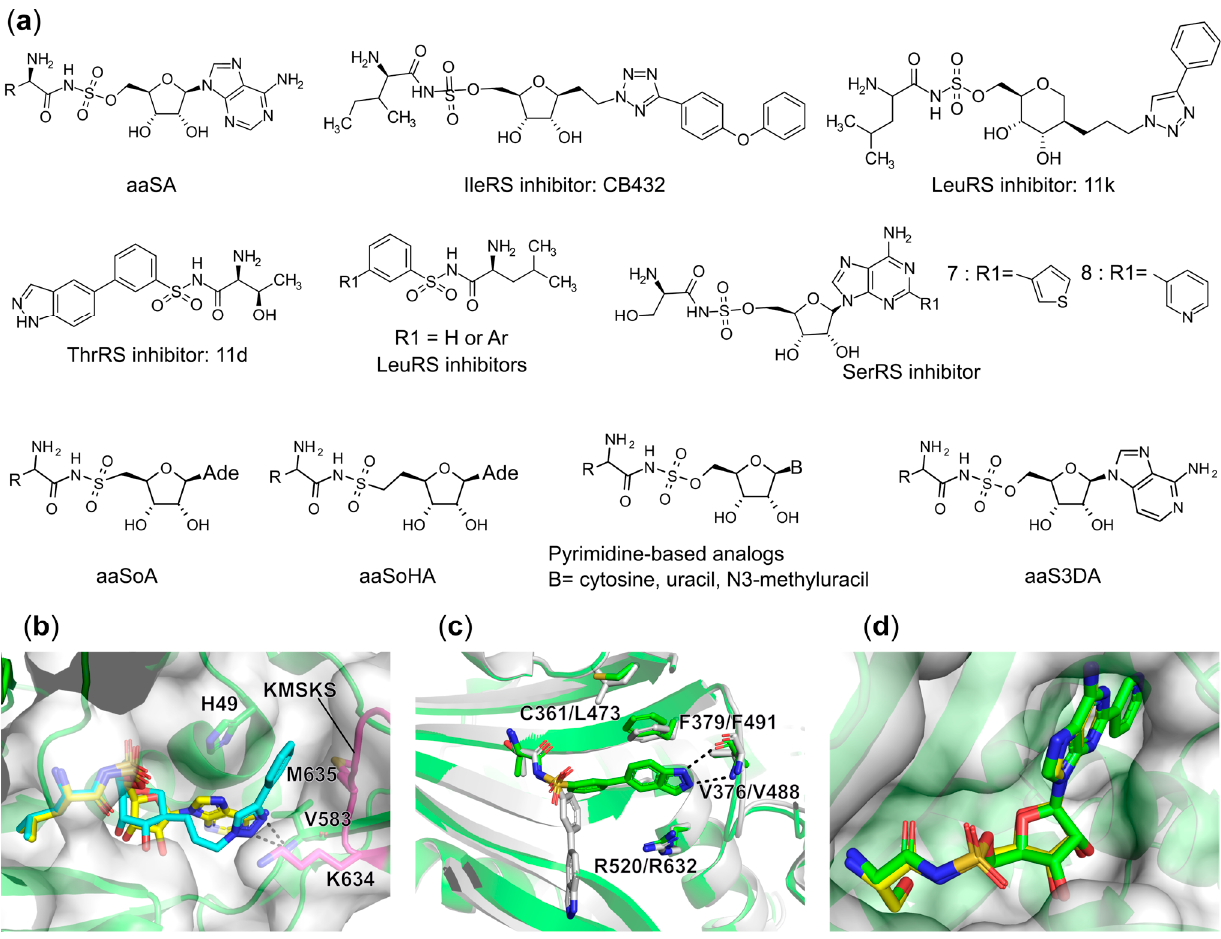
Figure 10. Synthetic aaRS bi-substrate inhibitors. ( a ) Chemical structures of synthetic aaRS inhibitors. The abbreviations are defined as follows: aaSA (aminoacyl-sulfamoyl adenosine), aaSoA (5 ′ -(N-aminoacyl)-sulfonamido-5 ′ -deoxyadenosine), aaSoHA (N-L-aminoacyl-C-5 ′ -adenosyl-methansulfonamide), and aaS3DA (aminoacyl-sulfamoyl 3-deazaadenosine). The R group corresponds to the side chain of a proteinogenic amino acid (aa) while Ade represents the natural adenine base. ( b ) Comparison of the binding modes of compound 11k (cyan C-atoms; PDB entry: 6YKL) and LSA (yellow C-atoms; PDB entry: 6Q89) in the aminoacylation site of N. gonorrhoeae LeuRS. The protein structure of the former complex is shown as a green cartoon representation covered by a transparent surface. The KMSKS loop region is colored in magenta. H-bonds are shown as black dashed lines. ( c ) Superposition of 11d bound to E. coli (green, PDB entry: 4HWR) and human ThrRS (grey, PDB entry: 4HWT). Important residues at equivalent positions in E. coli ThrRS and human ThrRS are indicated. ( d ) Superposition of E. coli SerRS in complex with seryl-sulfamoyl adenosine (SSA, yellow C-atoms, PDB entry: 6R1M) and compound 8 (green C-atoms; PDB entry: 6R1O). The protein backbone of the latter complex is shown as a cartoon representation (green) covered by a transparent